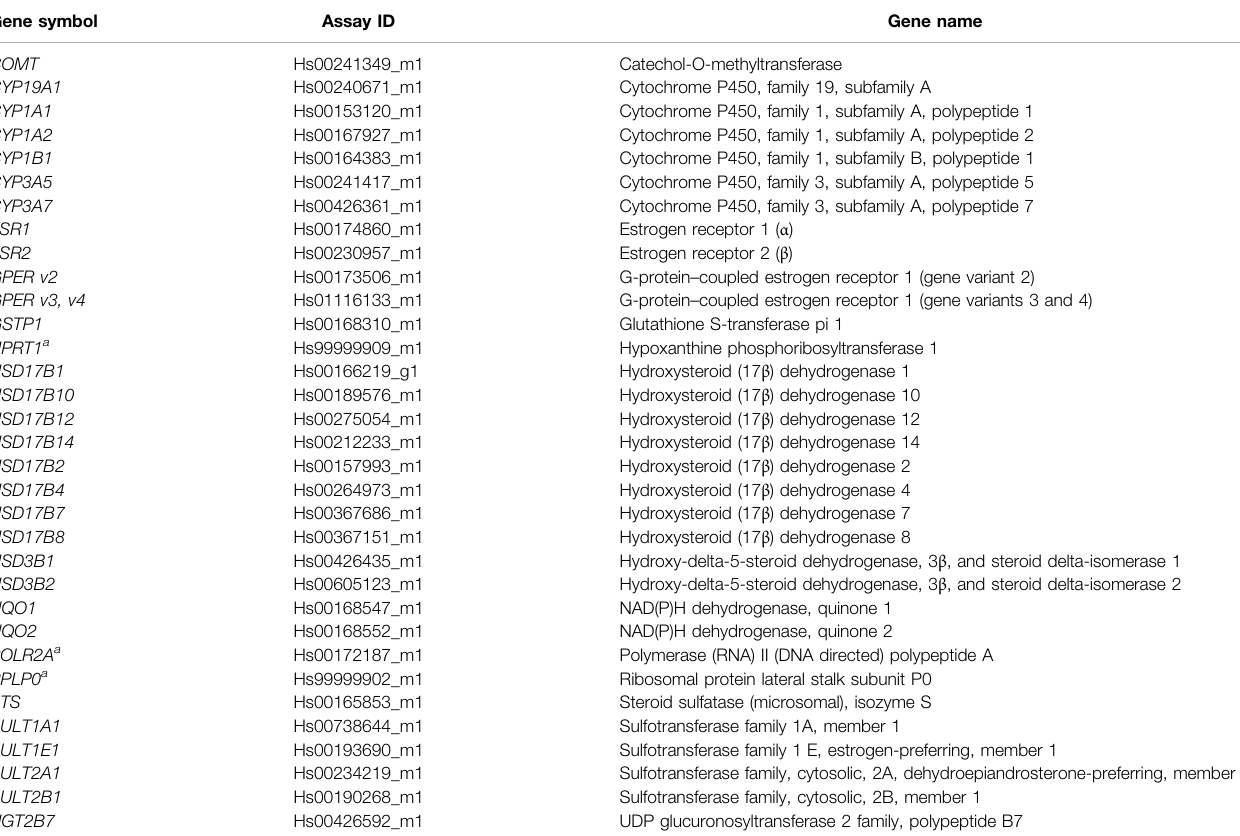
TABLE 1 | Details for the TaqMan “ Assays on Demand ” used for the genes investigated in this